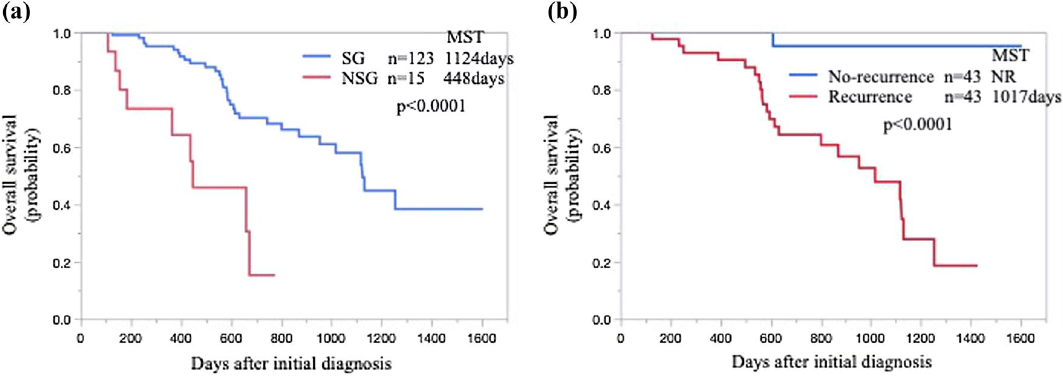
Fig. 2 Kaplan–Meier survival curves of patients. a Overall survival of all patients in the surgical and non-surgical group. b Overall survival of patients with and without recurrences in the SG-2 * . a , b The significant differences were analyzed by log-rank tests. MST Median survival time; NR not reached, NSG non-surgical group, SG surgical group. *SG-2: patients with pancreatic ductal adenocarcinoma who received neo- adjuvant chemotherapy with gemcitabine plus nab-paclitaxel following R0/R1